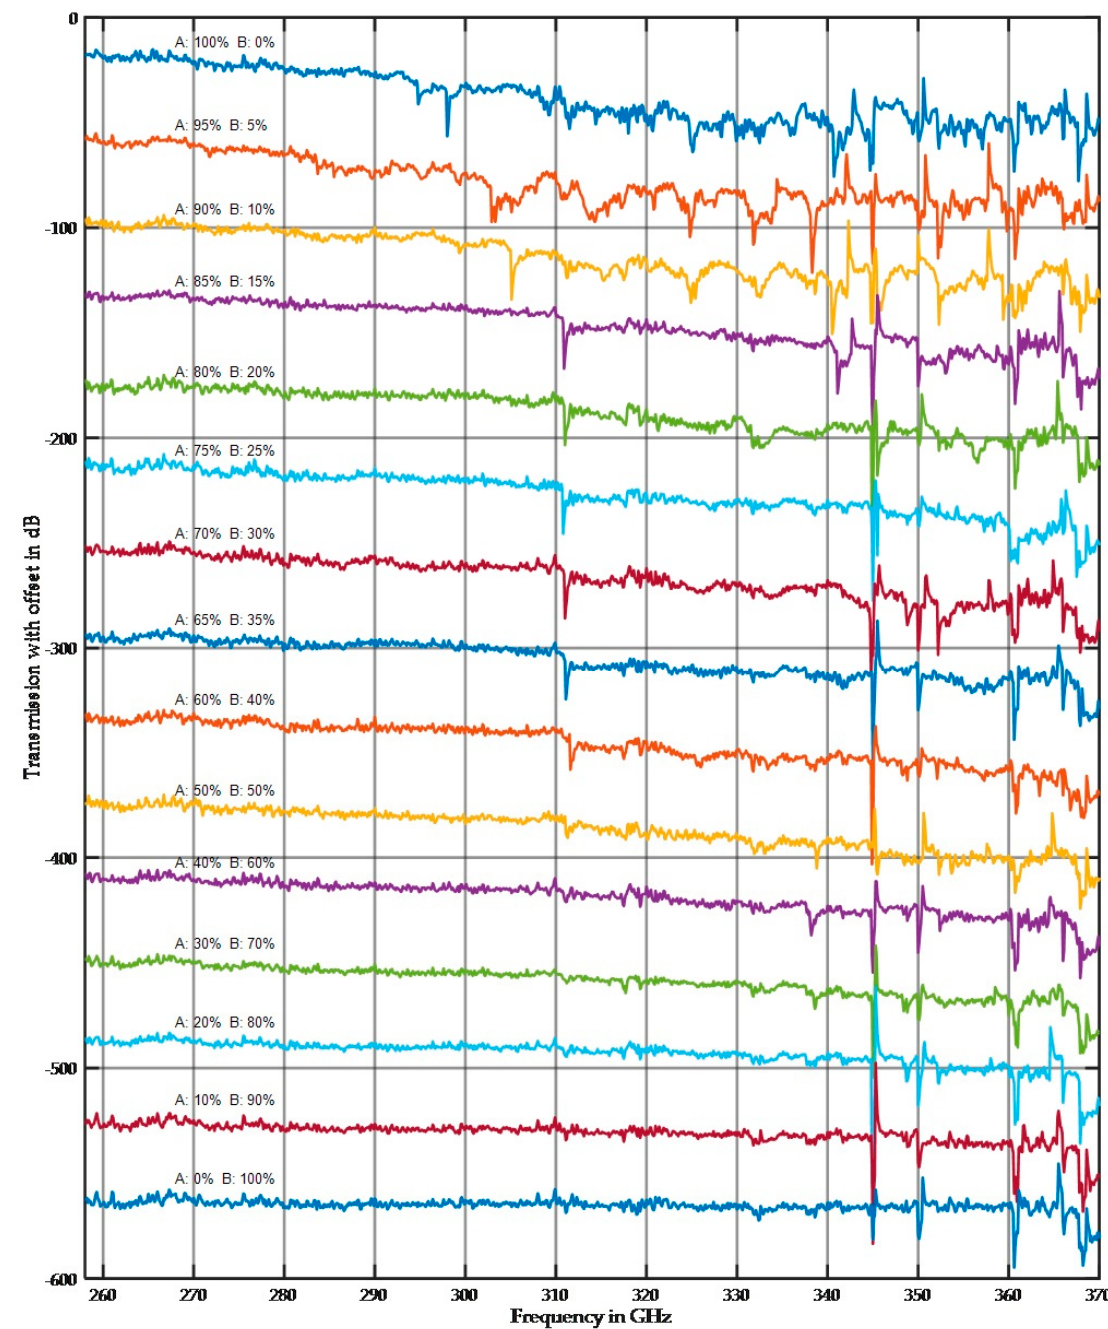
Figure 15. Measurement of mixed fractions. Fraction A is a 0.4–0.5 mm fraction, and fraction B is a 63–100 µm fraction. The percent composition is indicated in the figure. Selected spectra were plotted.